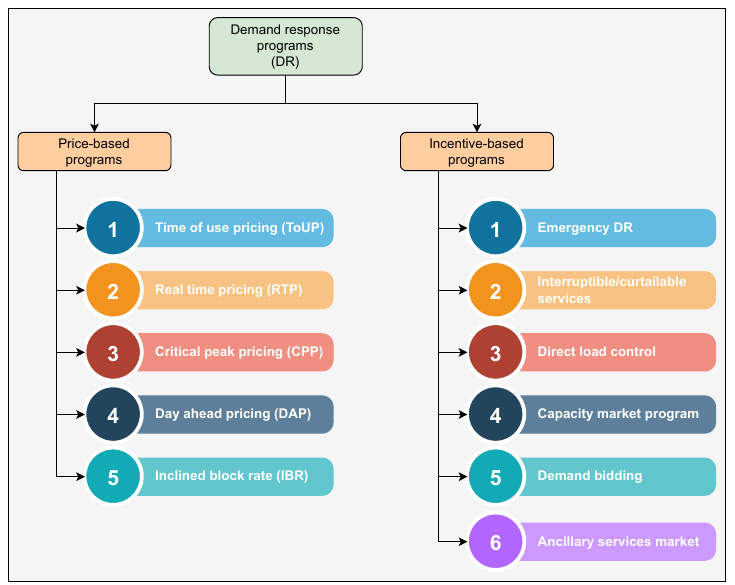
Figure 4. Types of demand response